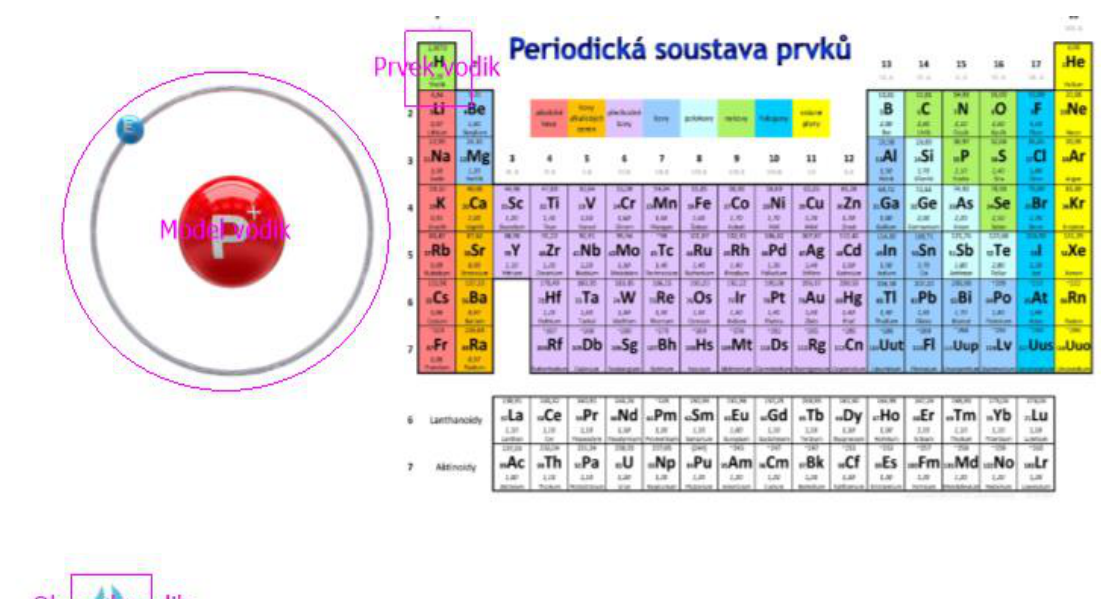
Fig. 1 Designation of AOI for